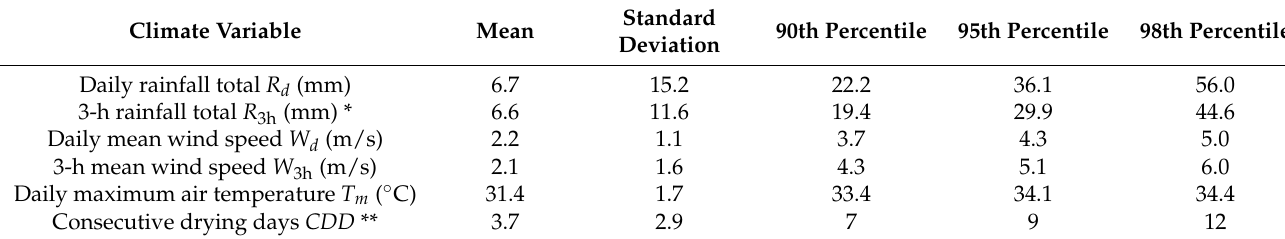
Table 1. Statistics and percentile-based thresholds of climate